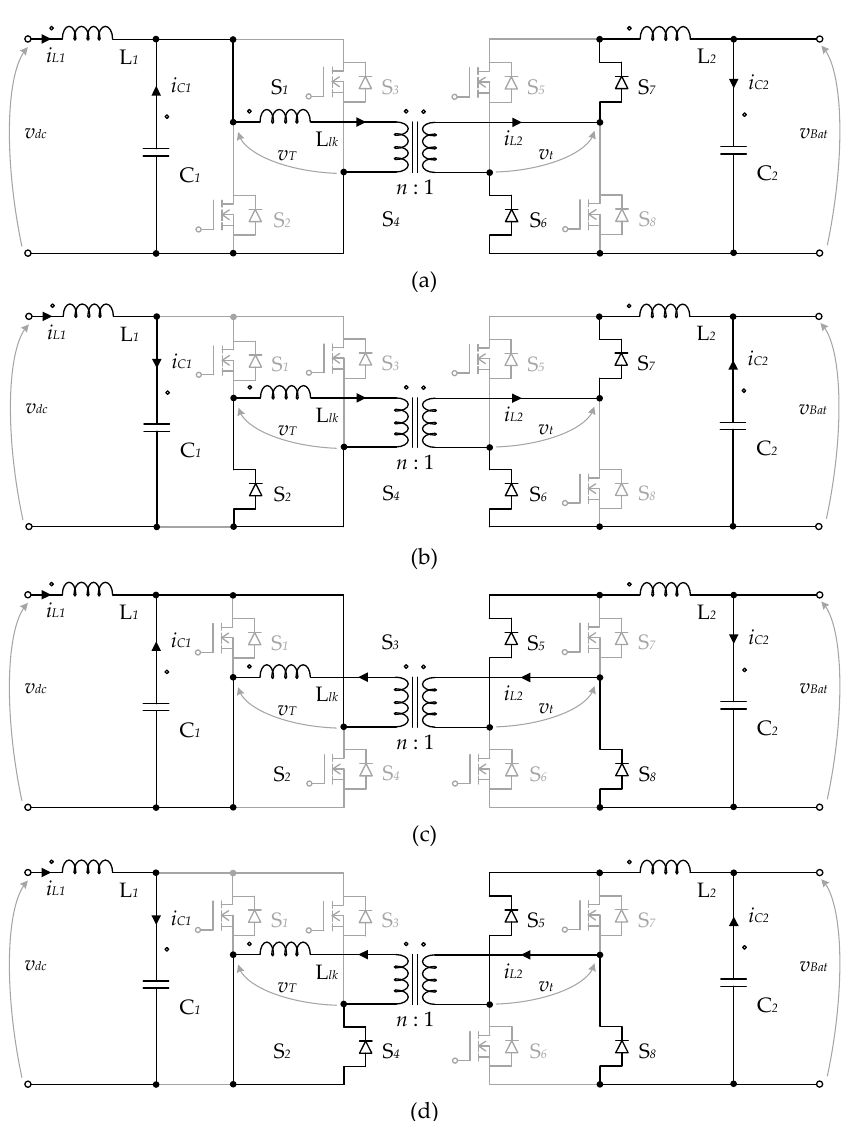
Figure 3. Equivalent circuits of the converter power stages operating in step-down mode, during battery charging: ( a ) Stage 1, ( b ) Stage 2, ( c ) Stage 3, ( d ) Stage 4.